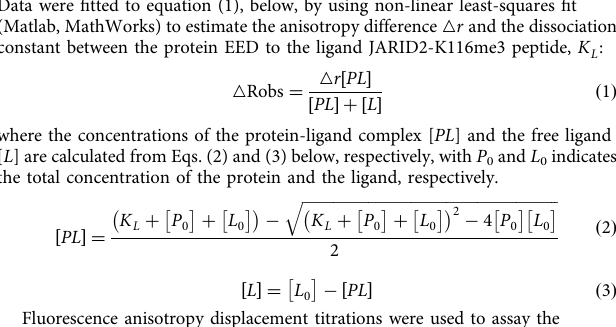
before a fl uorescence anisotropy measurement took place using a PHERAstar plate reader. Data processing was carried out as previously described 66 , with some modi fi cations. Speci fi cally, with changing the concentration of EED protein (P), we recorded 4 Robs: the observable anisotropy of the mixtures after the subtraction of the observable anisotropy of the 5-FAM labelled JARID2-K116me3 peptide ligand. Data were fi tted to equation (1), below, by using non-linear least-squares fi t (Matlab, MathWorks) to estimate the anisotropy difference 4 r and the dissociation constant between the protein EED to the ligand JARID2-K116me3 peptide, K L :